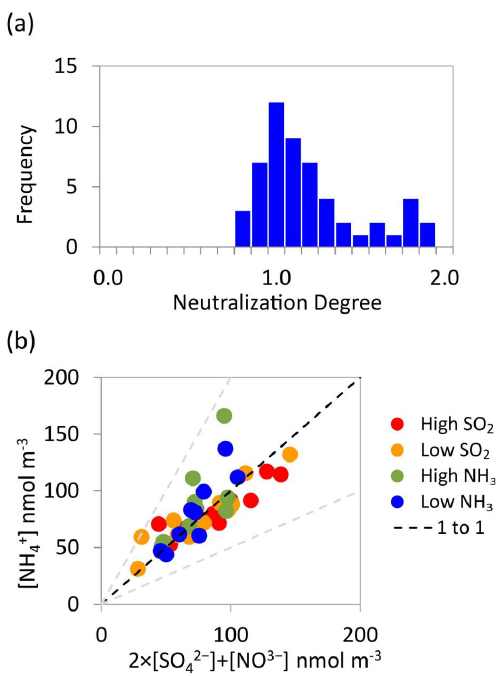
Fig. 8. (a) Frequency distribution of the neutralization degree from Figure 8. (a) Frequency distribution of the neutralization degree from aerosol samples (b) NH 4+ 692 aerosol samples (b) NH + to SO 2 − plus NO − ratios. 4 4 3 to SO 42– plus NO 3– ratios 693